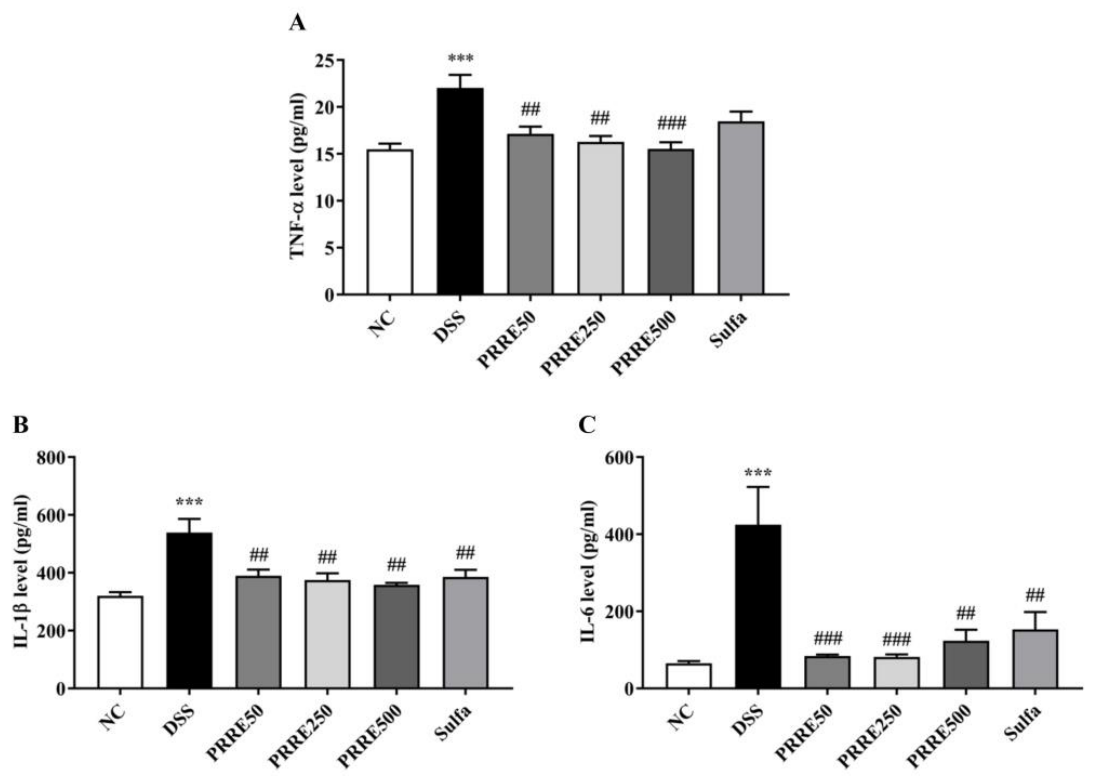
Figure 5. The effects of PRRE on productions of pro-inflammatory cytokine induced by DSS. The plasma levels of TNF- α ( A ), IL-1 β ( B ) and IL-6 ( C ). *** p < 0.001 vs. NC group, ## p < 0.01 and ### p < 0.001 vs. DSS group. NC = normal control mice treated with the vehicle, DSS = mice treated with DSS alone, PRRE50 = DSS mice treated with PRRE at 50 mg/kg/day, PRRE250 = DSS mice treated with PRRE at 250 mg/kg/day, PRRE500 = DSS mice treated with PRRE at 500 mg/kg/day and sulfa = DSS mice treated with sulfasalazine at 50 mg/kg/day.